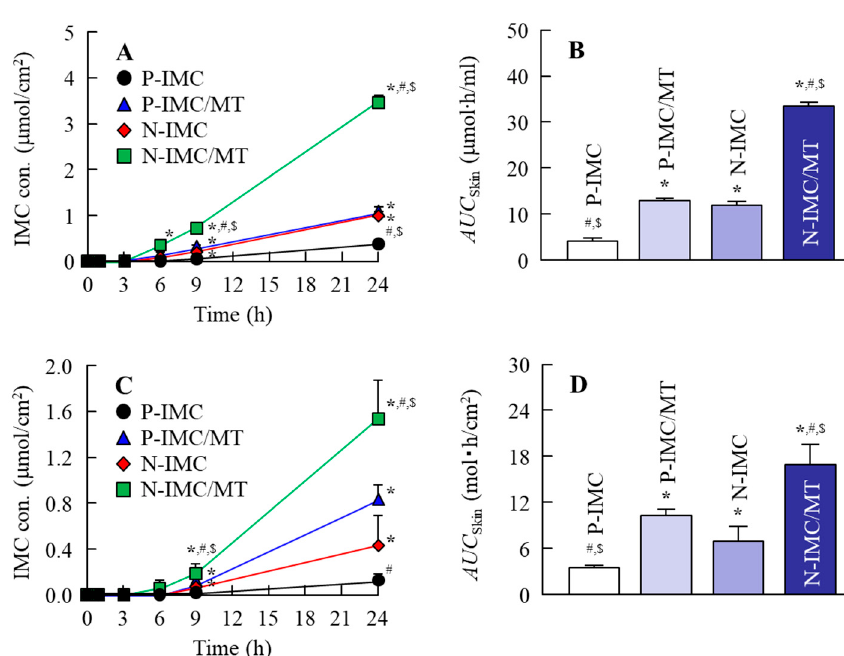
Figure 5. In vitro skin penetration of IMC transdermal formulations. ( A and B ); penetration ( A ) and AUC Skin ( B ) for the IMC transdermal formulations through rat skin under normal conditions (37 °C). ( C and D ); penetration ( C ) and AUC Skin ( D ) for the IMC transdermal formulations through rat skin under low temperature conditions (4 °C). n = 6–8. * p < 0.05 vs. P-IMC gel for each category. # p < 0.05 versus P-IMC/MT gel for each category. $ p < 0.05 vs. N-IMC gel for each category. The combination with l-menthol enhanced the skin penetration of IMC from both the microparticles-and SNPs-based transdermal formulations, and the AUC skin values for the N-IMC and N-IMC/MT gels were 2.9 and 2.6-fold higher in comparison with the corresponding microparticles-based transdermal formulations, respectively. Although skin penetration from the P-IMC/MT gel did not differ significantly between 4 °C and 37 °C, the skin penetration from the N-IMC/MT gel was remarkably attenuated at 4 °C.